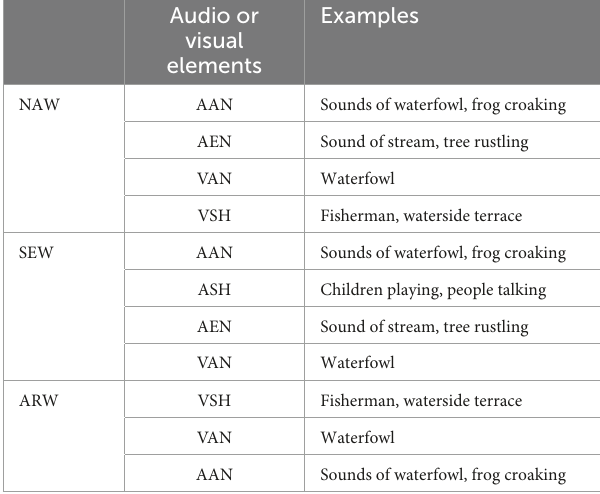
TABLE 5 Recommended types of audio and visual elements used in urban waterfront spaces.